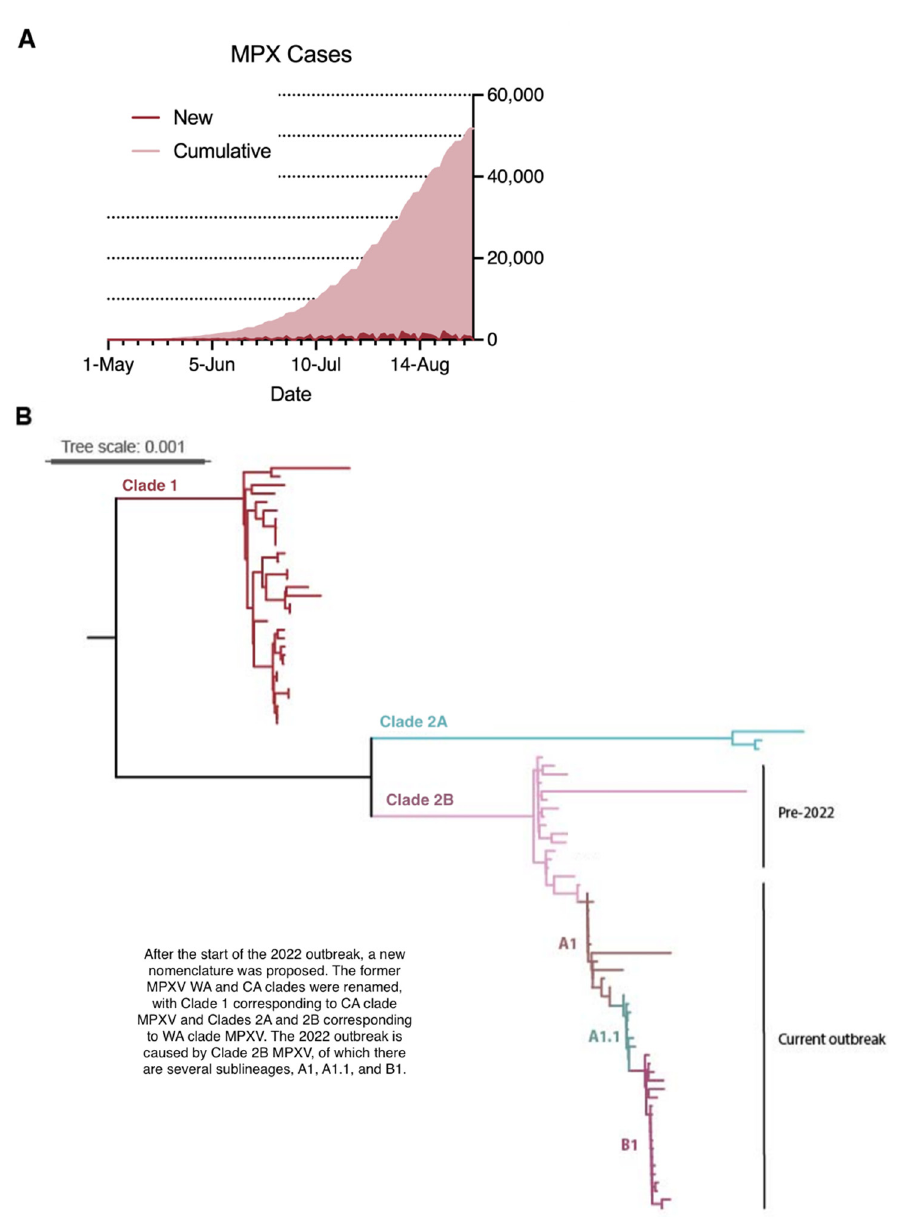
Figure 4. Epidemiology and phylogeny of the current outbreak. ( A ) Epidemic curve of daily new cases and cumulative total cases in non-endemic countries from 1 May 2022 to 1 September 2022. Data were retrieved from Global.health (https://github.com/globaldothealth/monkeypox) (accessed